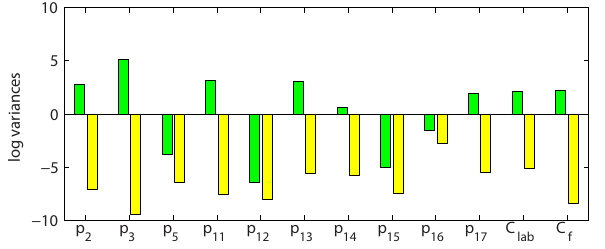
Figure 7. Diagonal elements (log scale) of the unit covariance ma- trix for the LAI operator: using the pseudo-inverse shown in green and TSVD shown in